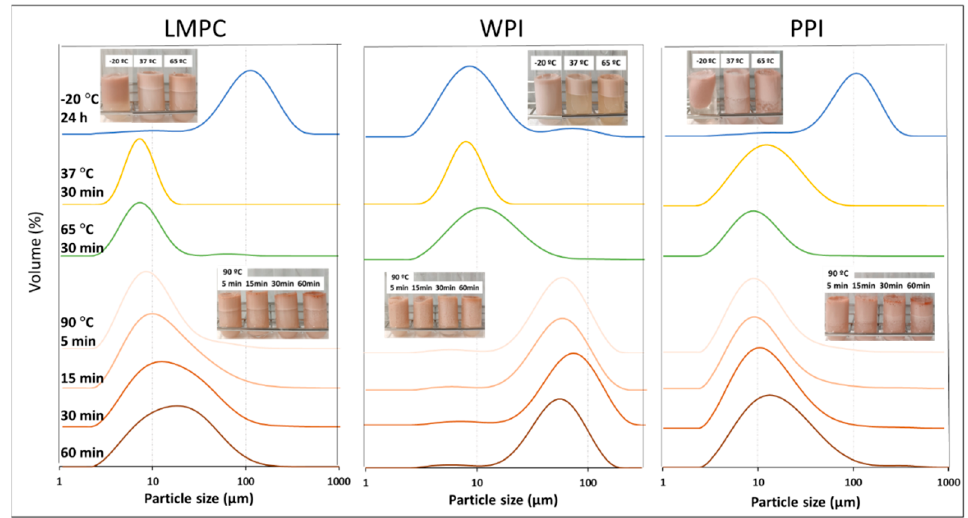
Figure 8. Droplet size distribution of W 1 /O/W 2 emulsions stabilized with LMPC, WPI, and PPI after simulated heat-storage/-treatment conditions (— –20 ◦ C for 24 h, — 37 ◦ C for 30 min, — 65 ◦ C for 30 min, and 90 ◦ C for — 5 min, — 15 min, — 30 min and — 60 min), and visual appearance of the